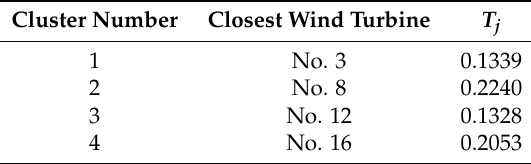
Table 1. Clusters’ power-tracking model.